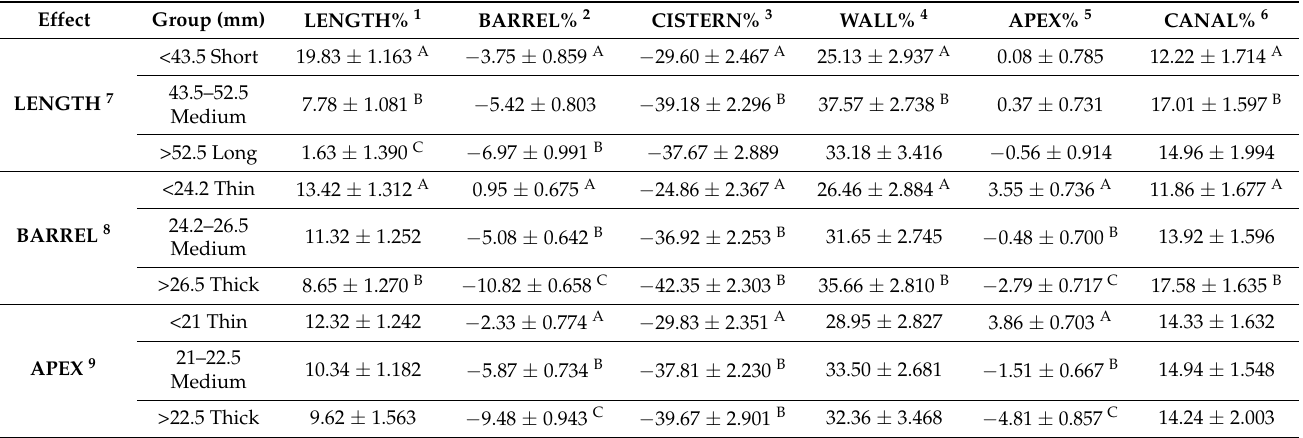
Table 2. The effect of teat length, barrel thickness, and apex thickness on the least-square means ± SEM of milking-induced changes in teat